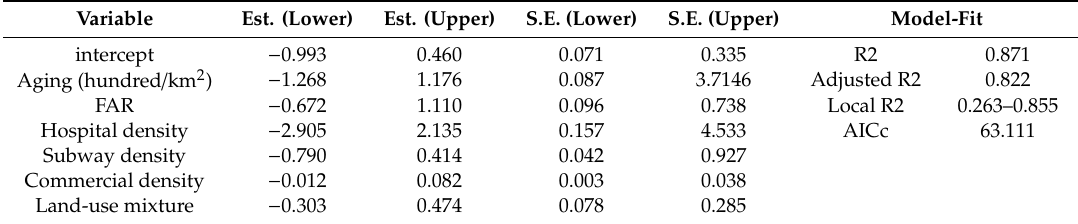
Table 4. GWR model